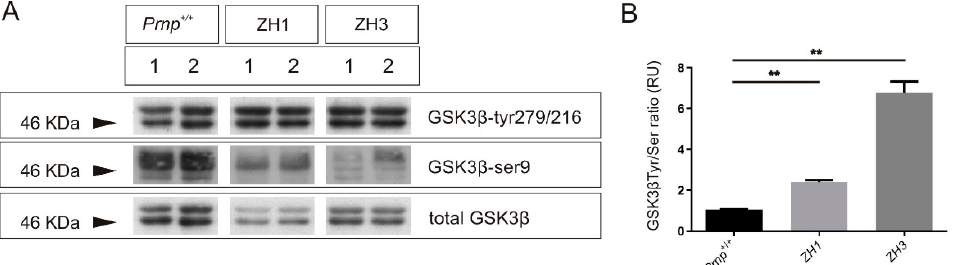
man P301S), we also observed a significant 1.26-fold decrease (* p = 0.0472) in total tau levels with WB in mice lacking PrP C expression, and in this case both endogenous (lower band of around 55 KDa) and overexpressed (upper band of 70 KDa) (Figure 4A,B). In addition, immunohistochemical analysis of P301Sx Prnp 0/0 animals showed a slight de- crease in Tau5 staining in the dentate gyrus (Figure 4C). Lastly, and taking into account that the mutant tau band is a 4R form, we analyzed endogenous tau splicing isoforms (both 3R and 4R) with WB (Figure 4D–G). Although results for individual isoforms were not significantly changed in PrP C knock-out mice (Figure 4D–F), the 3R/4R tau ratio from P301Sx Prnp 0/0 mice presented a significant 1.69-fold increase (* p = 0.0459) when compared to P301S (Figure 4G). In addition, WB analysis of the GSK3 β tyr/ser ratio suggested a cor- relation between the 3R/4R tau ratio and kinase activation, as P301Sx Prnp 0/0 mice showed a significant 1.28-fold increase (* p = 0.0319) when compared to P301Sx Prnp +/+ (Figure 4H,I). Taken together, our results indicated that in a similar manner to ZH1 and ZH3 ani- mals, loss of PrP C induced a significant reduction of total tau expression both in a mutated and non-mutated tau transcript, and a significant alteration of endogenous 3R/4R tau ratio in favor of 3R isoforms in both models.